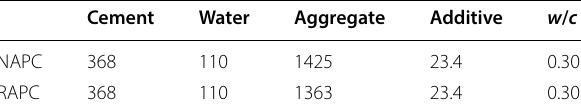
Table 2 Mix proportions for pervious concrete (kg/m 3 ).